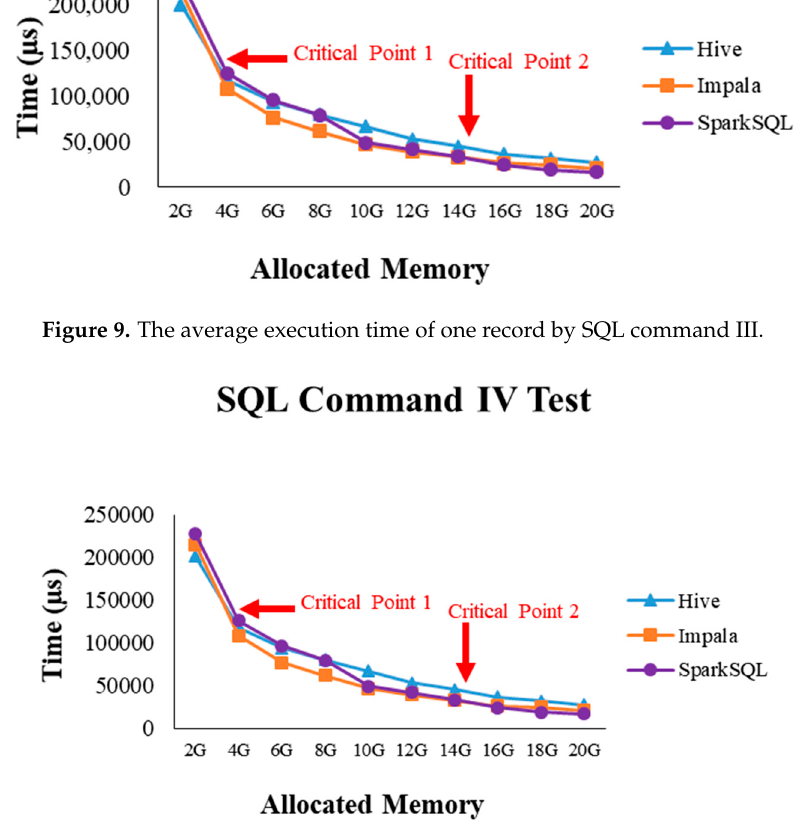
Figure 10. The average execution time of one record by SQL command IV.